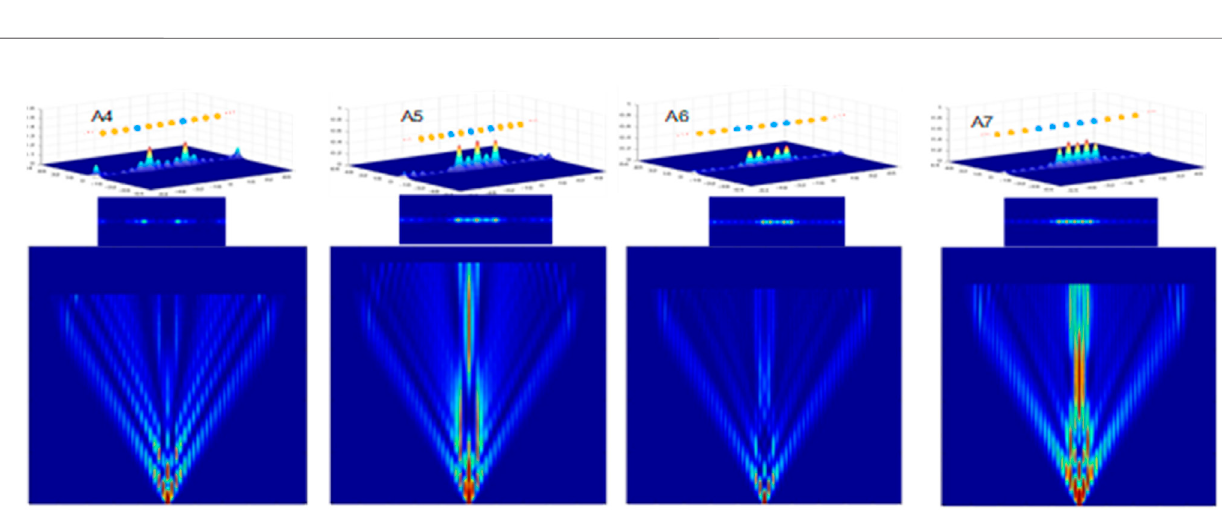
the bottom to the top in each panel as follows: the 3D-distribution